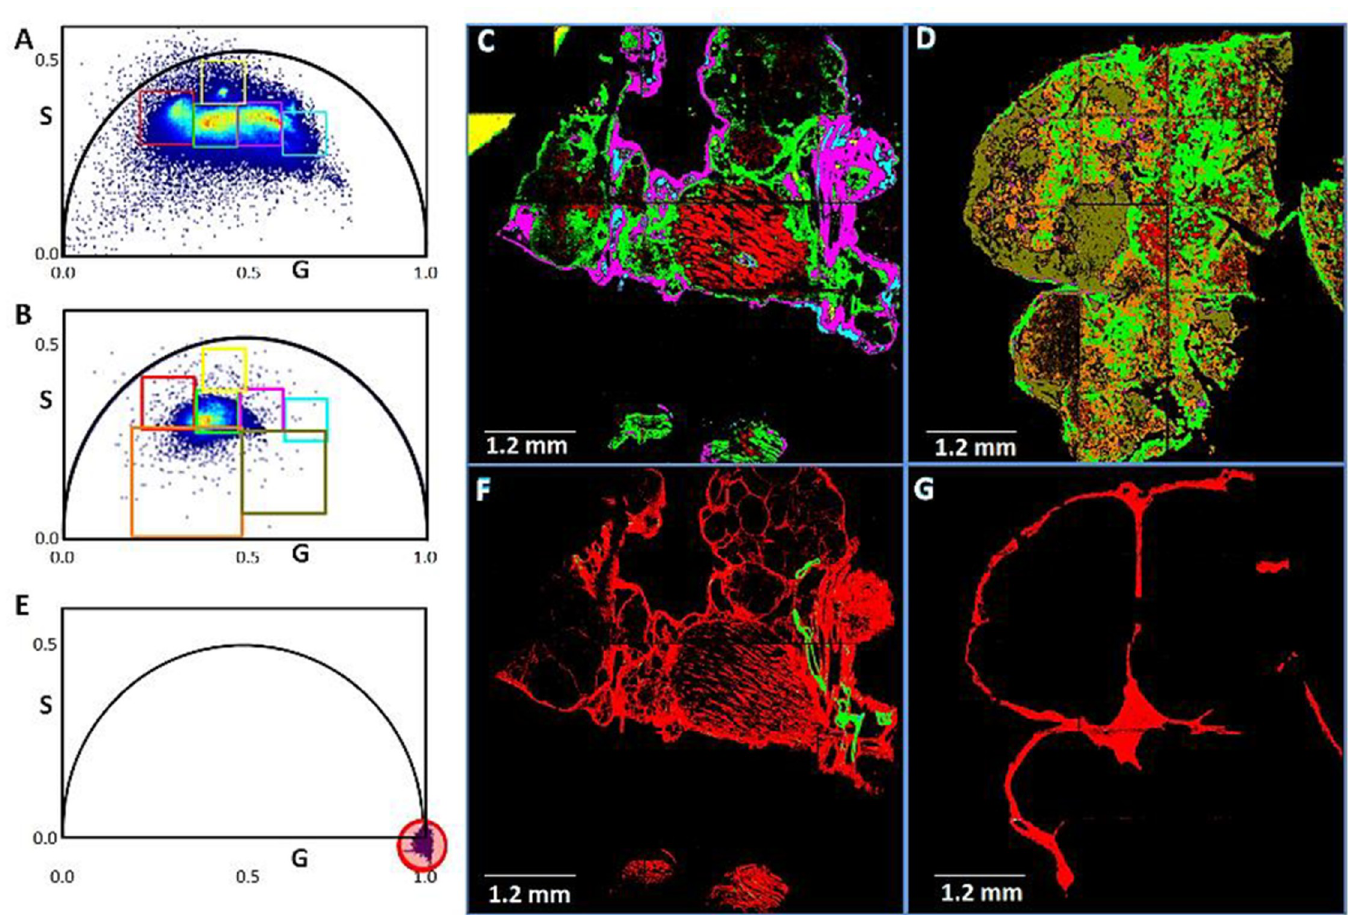
Fig 4. FLIM and SHG analysis of mammary tumors from control and DMHCA-treated NeuT/ATTAC mice receiving AP21087. FLIM: The red cursor shows the collagen I phasor signature, where the control tumor ( A ) has a larger spread of phasor points compared to the tumor from the DMHCA-treated animal ( B ), and indicates tumor heterogeneity. Multiple cursors selected areas of the phasor clouds for the control tumor ( A ) DMHCA-treated tumor ( B ). The control tumor shows excessive collagen I deposition shown by the red shading ( C ), as well as pink and cyan shading, which are largely absent in the DMHCA-treated tumor ( D ). The orange and olive green shading in the DMHCA-treated tumor ( D ) emphasize the changes occurring in the TME as a result of DMHCA treatment. SHG: SHG is generated from the interaction of light with the non-centrosymmetric structure of collagen I fibers (red shading), and indicates fibrosis. E , The phasor signature of SHG (red shaded cursor) is separated from fluorescence and appears at G = 1, S = 0), since the harmonic generation signal is not delayed compared to fluorescence, and the phasor from fluorescence appears inside the universal black semi-circle. Extensive collagen deposition is present in the control tumor ( F ) and is largely absent in the DMHCA-treated tumor ( G ), indicating a marked reduction in fibrosis. The areas represented in F and G are the same areas shown in C and D , respectively. Scale bar, 1.2 mm.